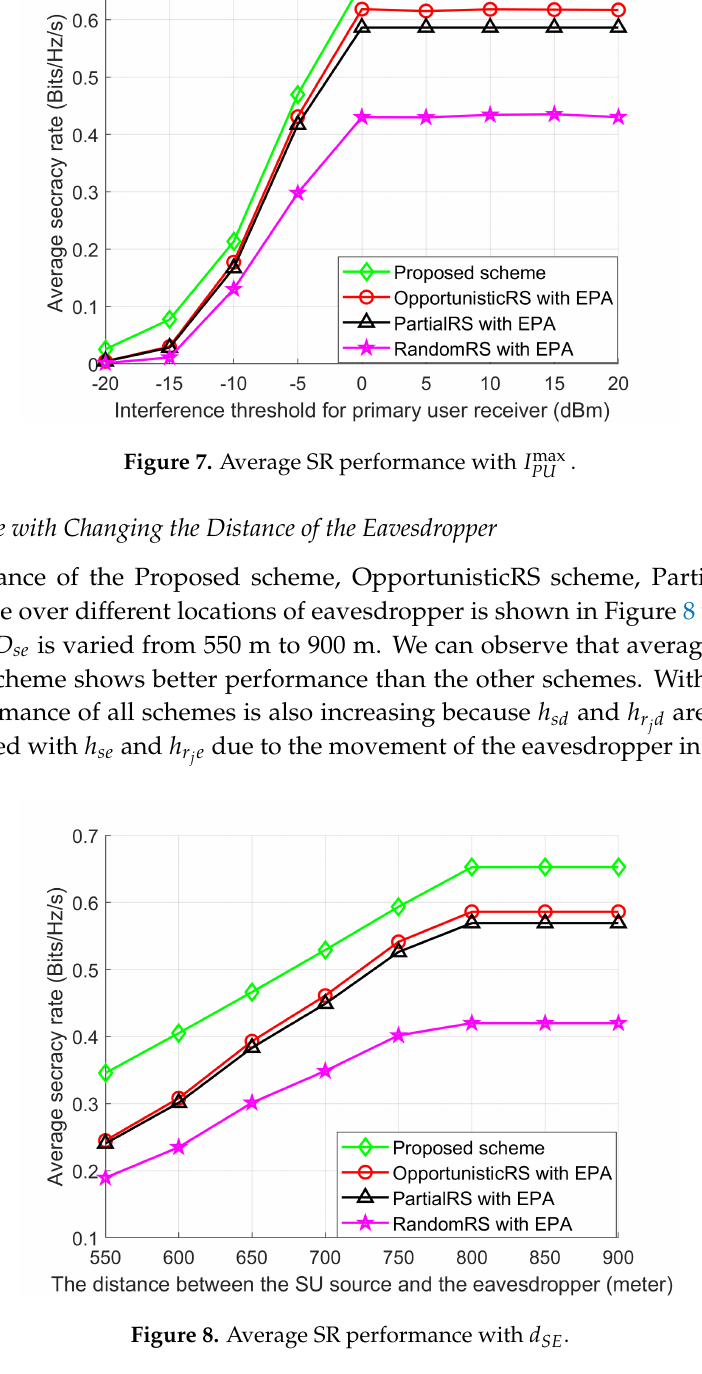
Figure 8. Average SR performance with d SE